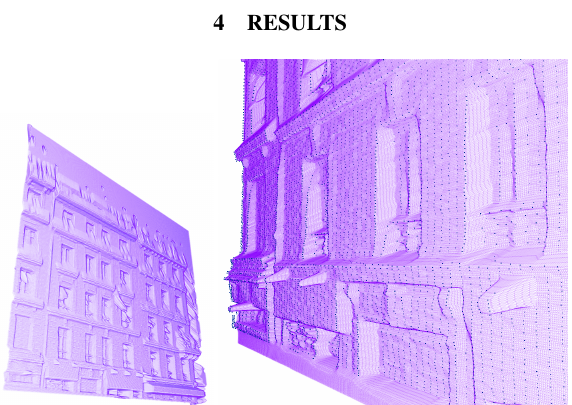
Figure 13: Grid constructed for a facade (left). Detail of the grid